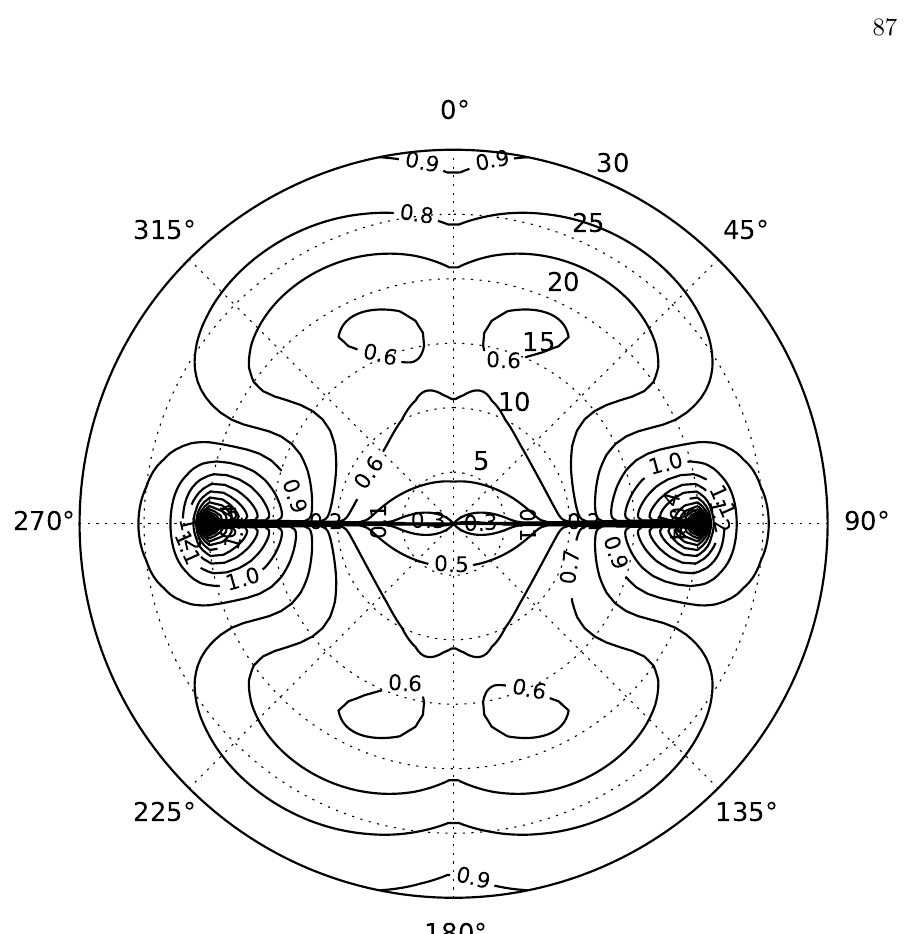
Fig. 4. Isolines of the correction factor of gravity, C g . The coordinates are the same as in Figure 1. Similarly to the gravitational potential, in the outer region free of isolines the value of C D asymptotically approaches to 1.0, and the central value of the correction factor is zero. The maximum correction factors are found on the galactic plane at D =